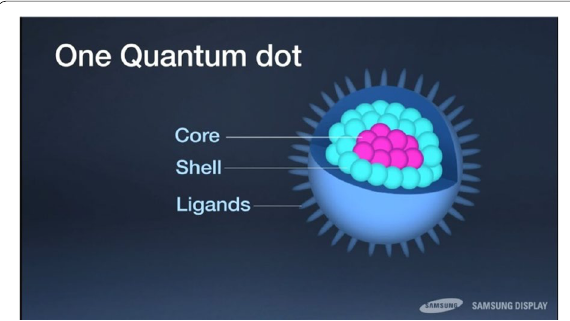
Fig. 4 Schematic representation of quantum dots [14, 15]